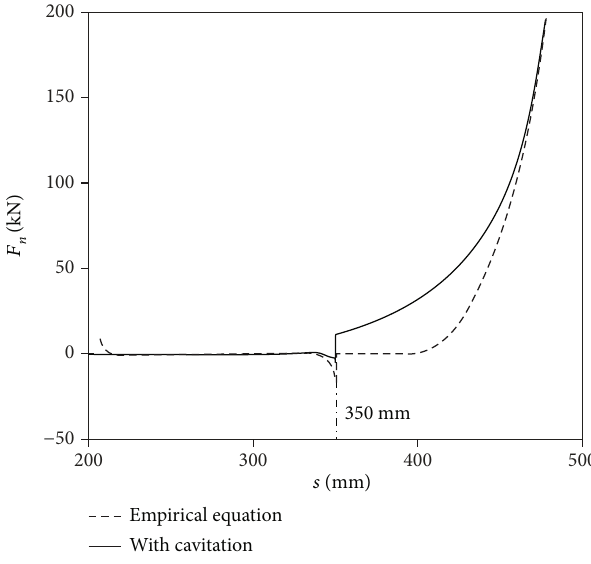
Figure 8: Comparison of e ffi ciency diagrams.